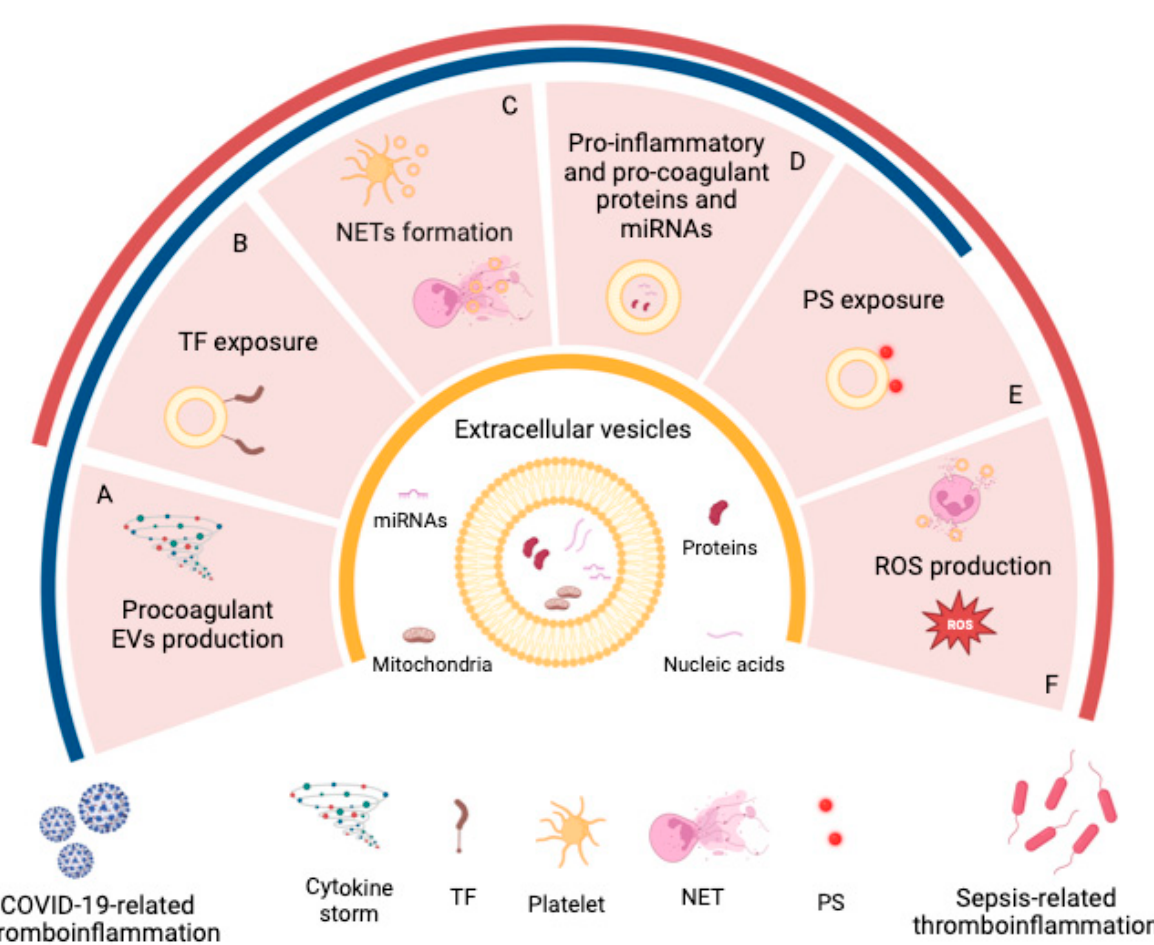
Figure 1. Extracellular vesicles as new players in sepsis- and COVID-19- thromboinflammation. Schematic summary of some of the main roles of EVs in sepsis- (red line) and COVID-19- (blue line) related-thromboinflammation. ( A ) The cytokine storm occurring during sepsis and COVID-19 might influence the cell release of substantial amounts of procoagulant EVs involved in thromboinflamma- tion development. ( B ) Higher amounts of TF-positive EVs are associated with an increased occurrence of both DIC in sepsis and thrombosis in COVID-19. ( C ) Activated platelets release EVs that promote excessive NET formation both in sepsis and COVID-19. ( D ) Protein and miRNA cargo in EVs could contribute to the pathogenesis of thrombotic complications in sepsis and COVID-19 patients. ( E ) EVs exhibit direct procoagulant properties due to PS expressed on their surfaces in sepsis and (probably) in COVID-19 patients. ( F ) Leukocyte-derived EVs contribute to thromboinflammation via excessive ROS production. TF, tissue factor; NETs, neutrophil extracellular traps; PS, phosphatidylserine; ROS, reactive oxygen species. Created with